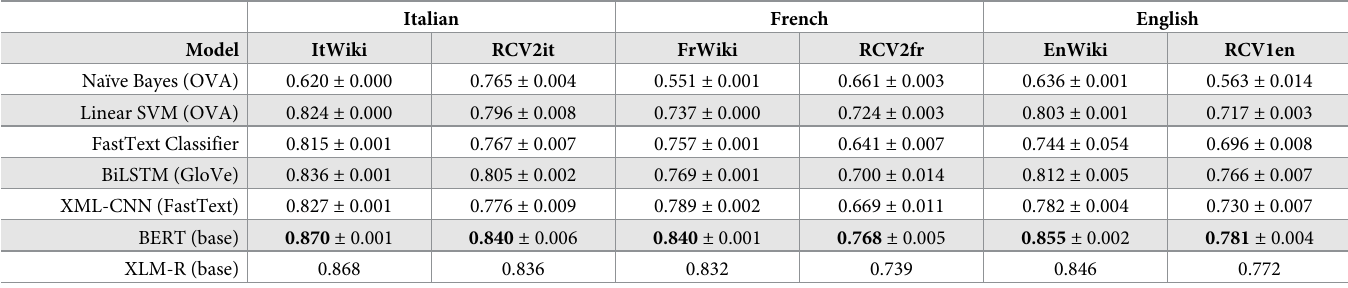
Table 10. Test set macro F1 score for the tested TC methods.